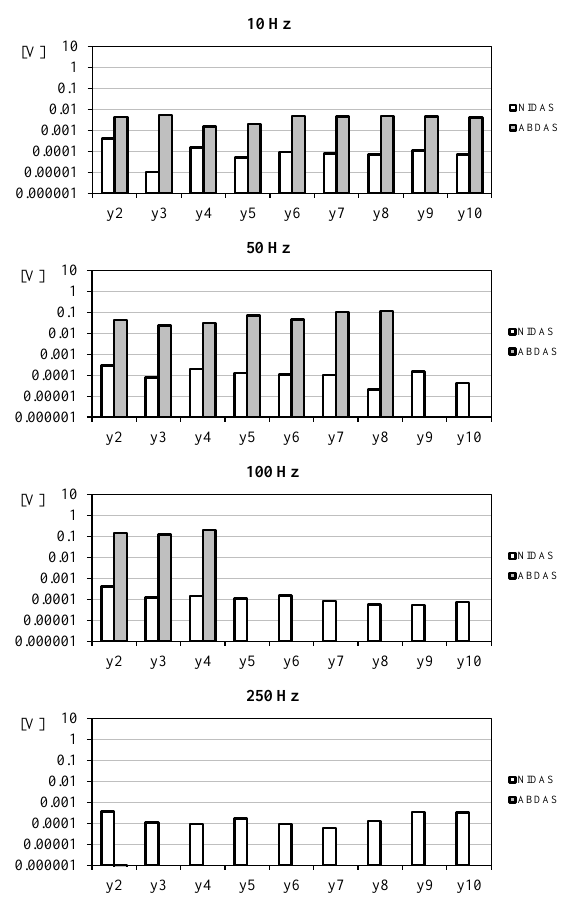
Figure 13. Harmonic terms, y 2 to y 10 , extracted from the sampled data of same signal (Equation (3)) measured with NIDAS and ABDAS. Sensors 2018 , 18 , x FOR PEER REVIEW